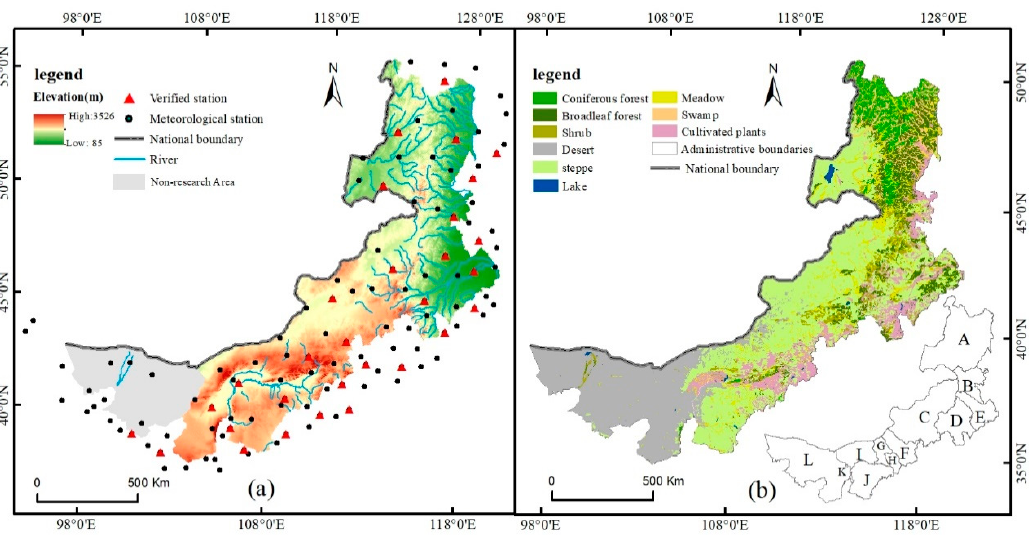
Figure 1. ( a ) The Digital Elevation Model (DEM) and meteorological station distribution, and ( b )